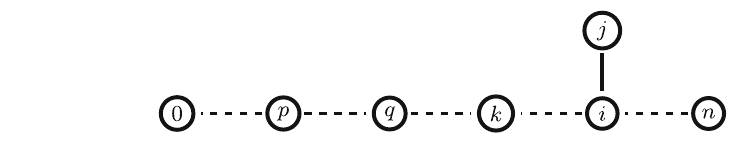
Figure 12: Minimum subgraph of C containing vertices {